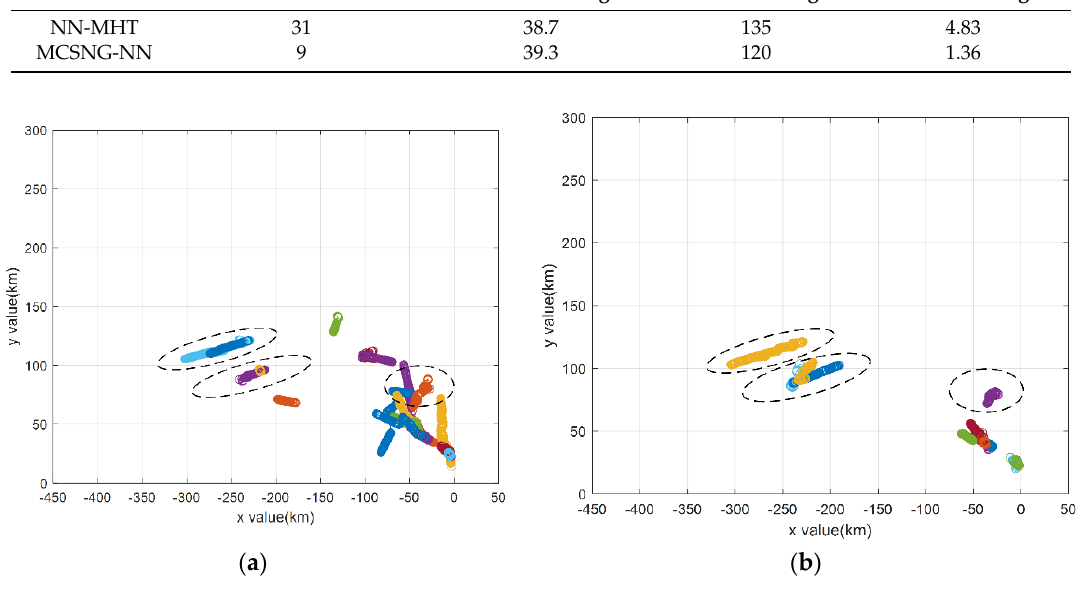
Figure 15. Tracing results of SNN-Kalman and MCSNG-SNN-K: ( a ) SNN-Kalman tracing result; ( b ) MCSNG-SNN-K tracing result. Table 8. The performance indexes of SNN-Kalman and MCSNG-SNN-K.